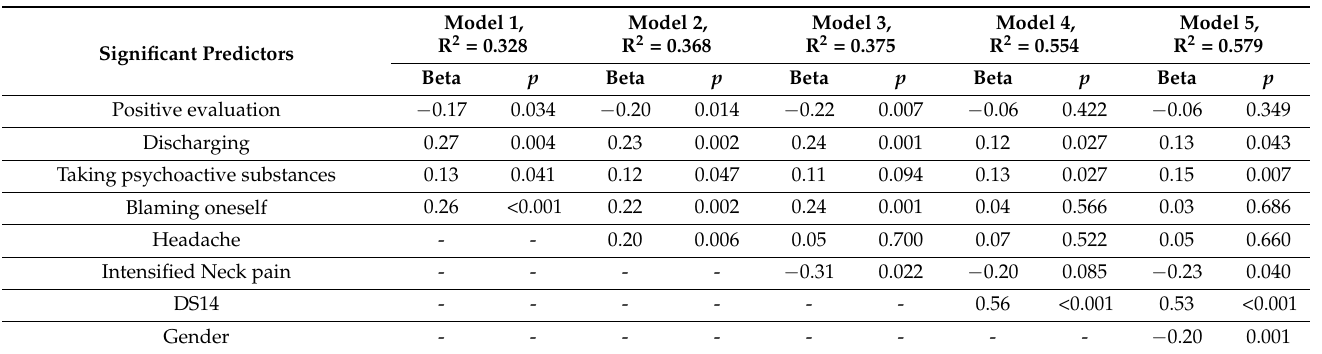
Table 5. Hierarchical regression analysis explaining the intensity of stress among students during the pandemic.